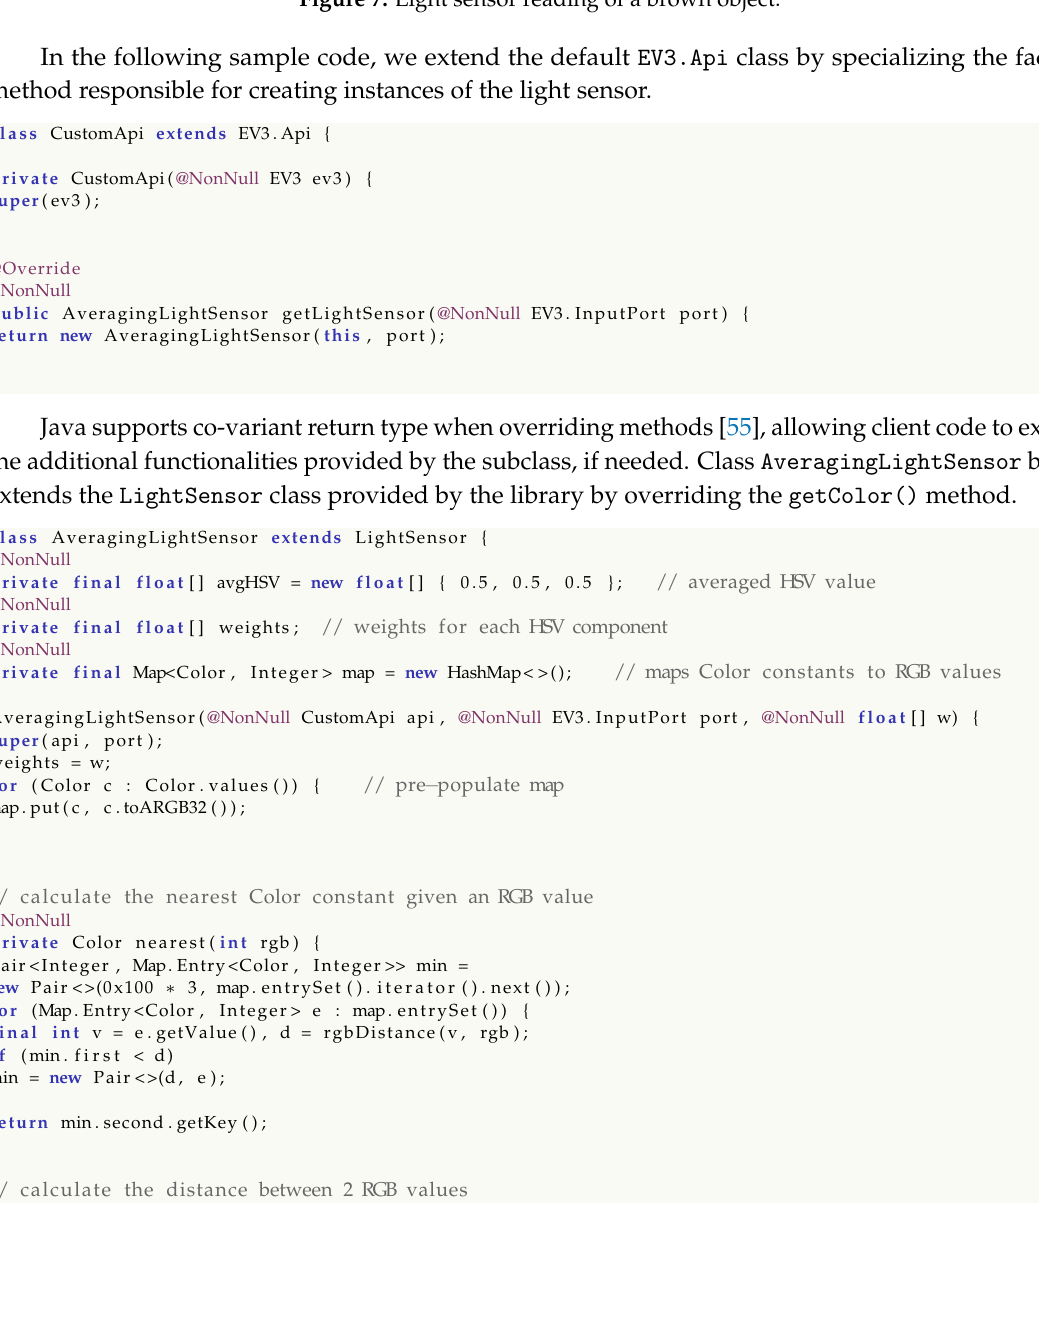
Figure 7. Light sensor reading of a brown